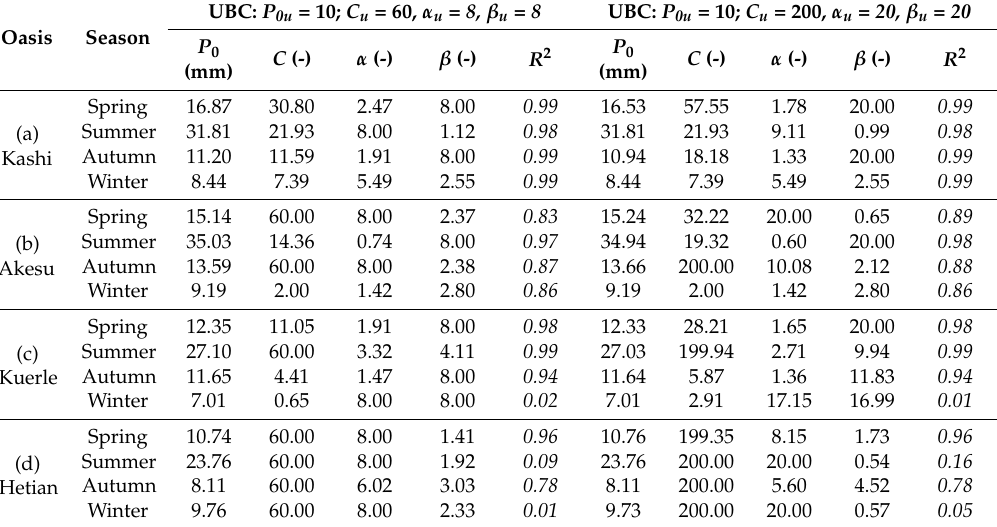
Table 2. Comparisons on the sensitivity of parameter with different upper boundary conditions (UBC) at seasonal scale. R 2 are indicated in italics and